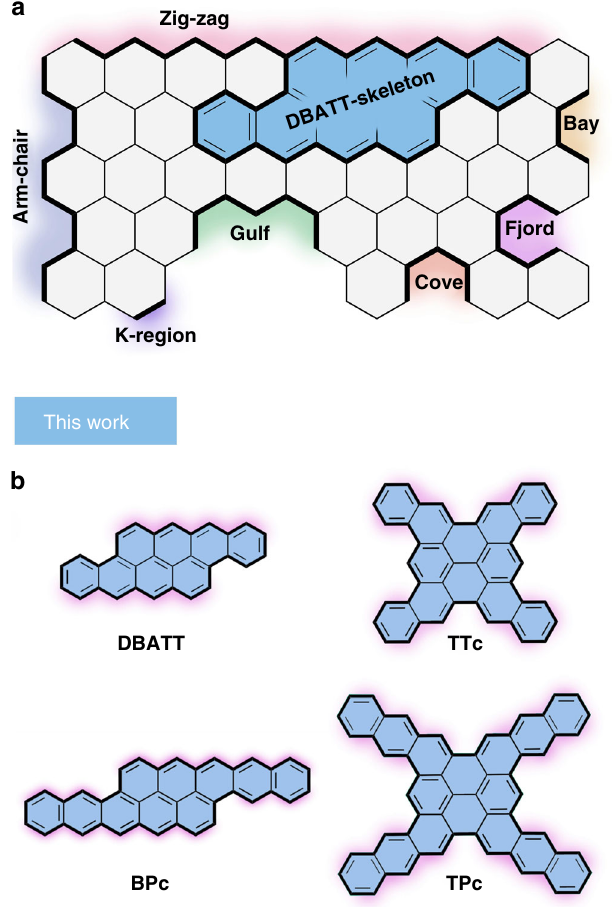
Fig. 1 Relevant terminologies and overview of this work. a Nomenclature and schematic depiction of relevant edge structures; b Herein enabled zig- zag NGs by the DPEX